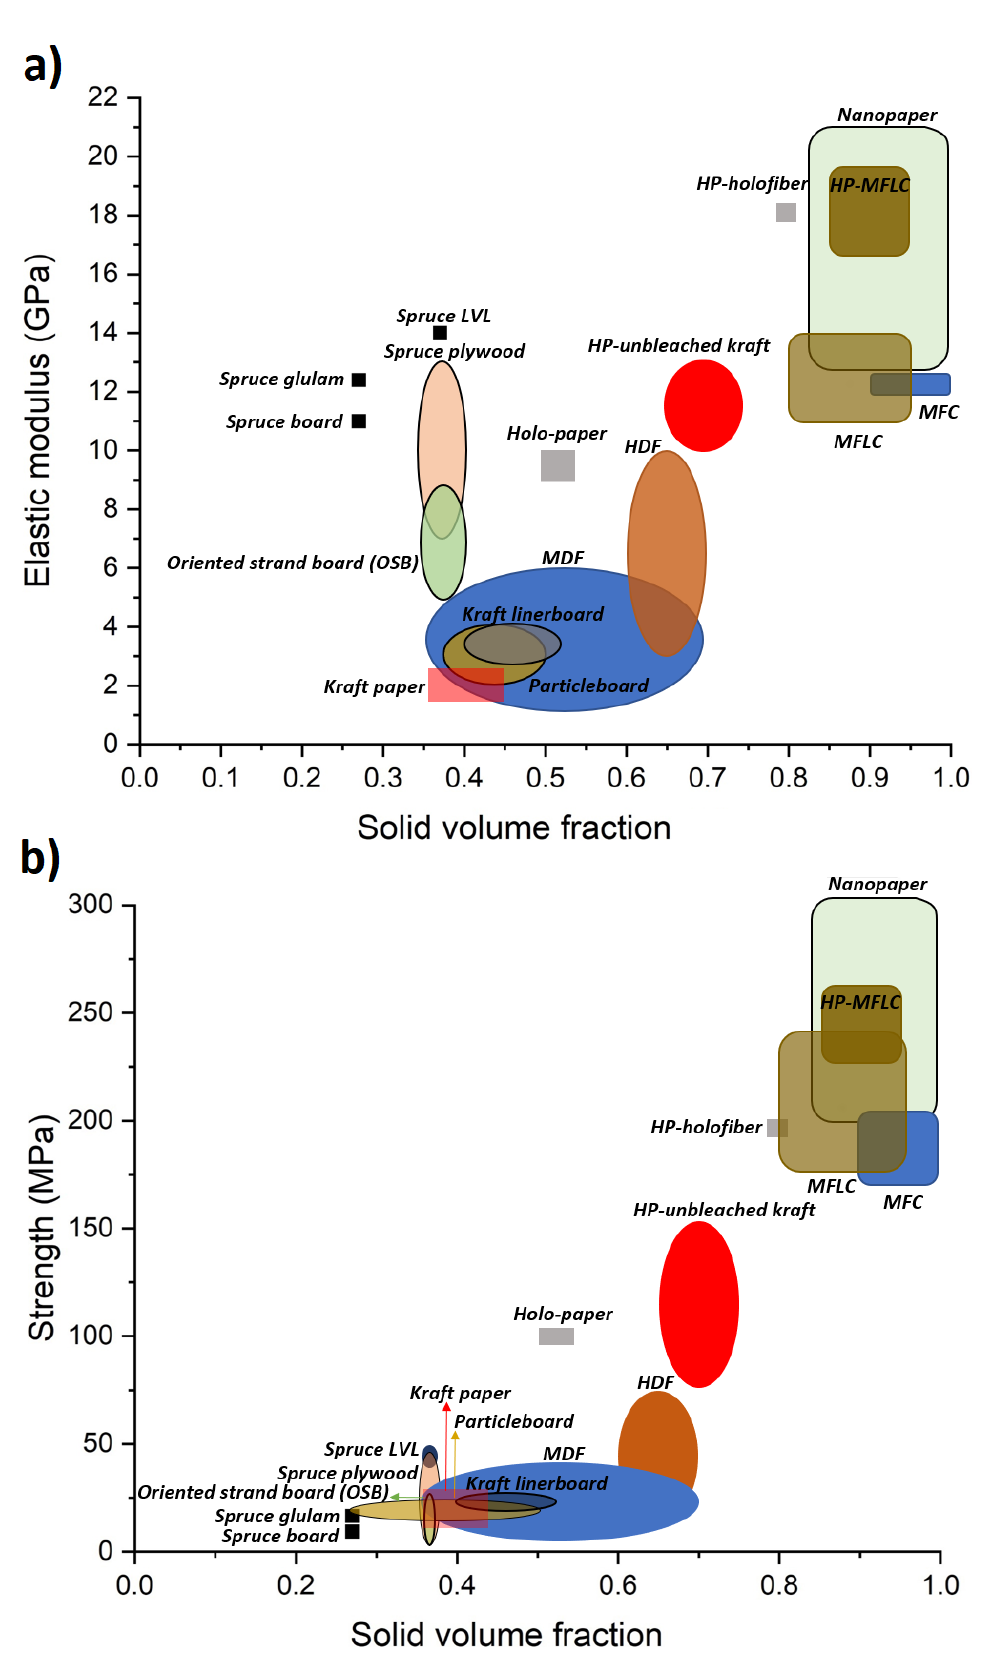
Figure 5. ( a ) Modulus and ( b ) strength versus solid volume fraction of different wood-based fiber materials. Data from Table 1 and refs [64,65] .